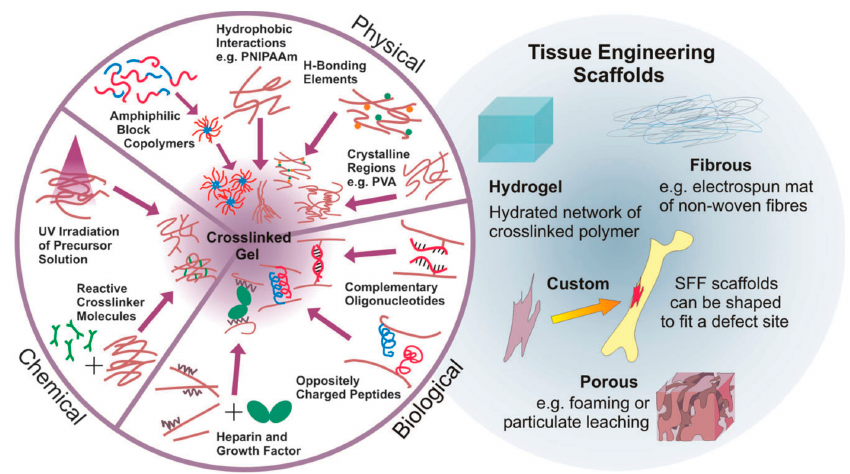
Figure 2. ( Left ): Alternatives to obtain crosslinked hydrogels. Hydrogels can be based on permanent, covalent links between polymer chains or physical (reversible) crosslink bonds based on a variety of non-covalent interactions (from synthetic and biological origin). ( Right ): Examples of TE scaffolds, including hydrogels, fibrous, custom and porous morphologies. Reproduced with permission from [8].